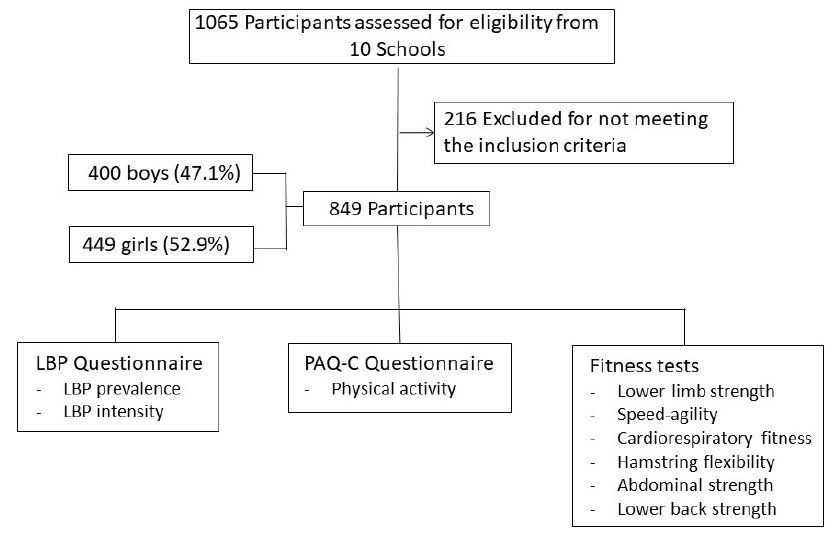
Figure 1. Flow Figure 1. Flow chart.